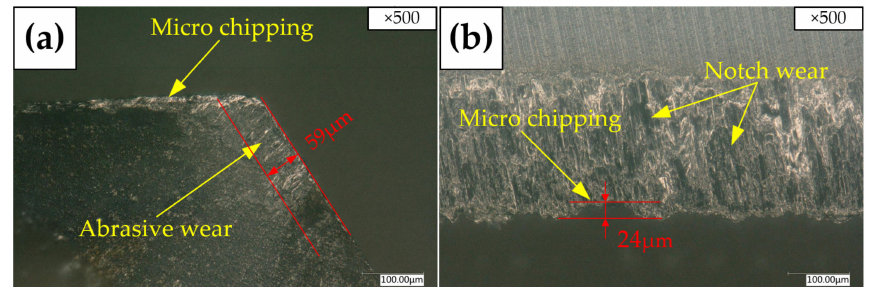
Figure 5. Tool wear morphologies with KEYENCE microscope of Tool A: ( a ) Rake face; ( b )